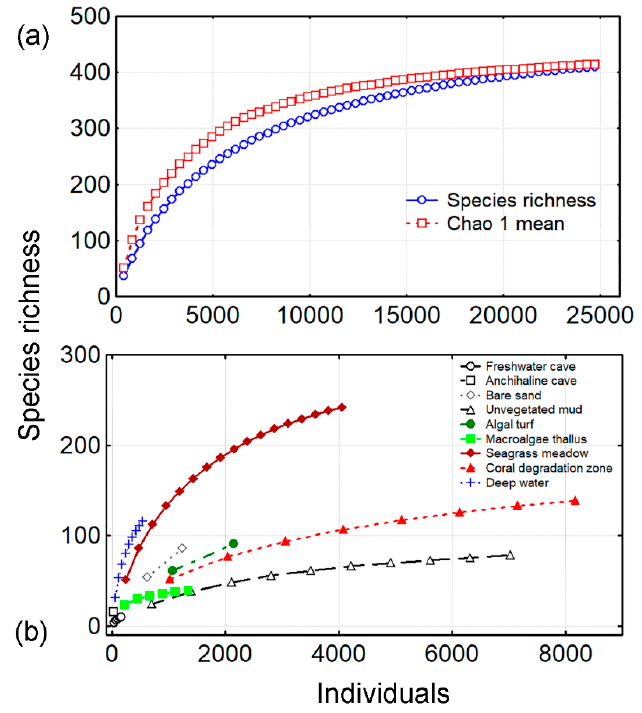
Figure 2. Accumulation curves of nematode species versus individuals. ( a ) For all the samples pooled using the observed species richness (SR) and the non-parametric estimator Chao 1; ( b ) the SR per habitat type. Diversity 2019 , 11 , x FOR PEER REVIEW